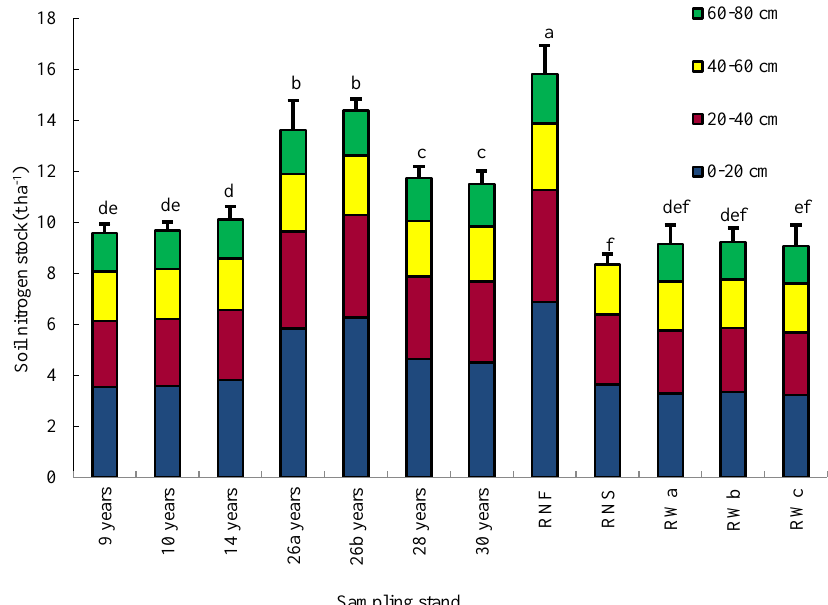
Figure 1. Soil nitrogen stocks at different depths in soil profile of plantations, reference wastelands, natural recovery shrub grassland (RNS) and reference natural forest (RNF) (t ha − 1 ). Note: RWa, reference wasteland in Dongchuan municipality; RWb, RWc: reference wastelands in Ningnan county. 26a, mixed plantation with L. leucocephala , Eucalyptus camaldulensis and Cajanus cajan , aged 26. 26b, mixed plantation with L. leucocephala and C. cajan , aged 26. Data are means ± stand deviation, with the same letters among stands denote insignificant differences ( p = 0.05).